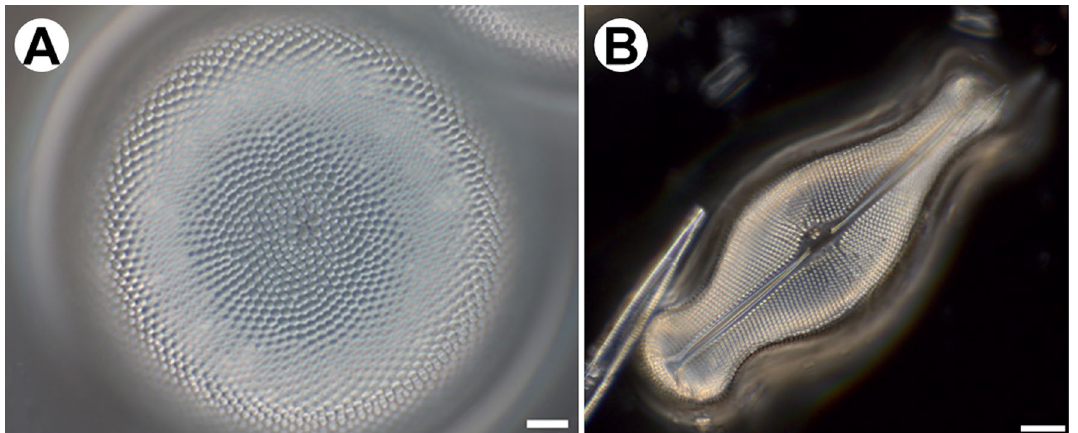
Figure 2. Light Microscopy (LM) images of ( A ) Coscinodiscus sp.; ( B ) Didymosphenia geminata . Scale bars: 10